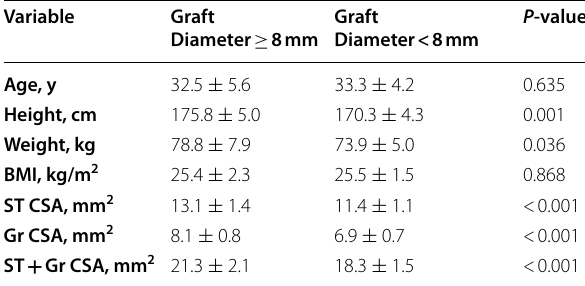
Table 2 Demographics and MRI measurements compared between groups with measured HT auto autograft diameter of